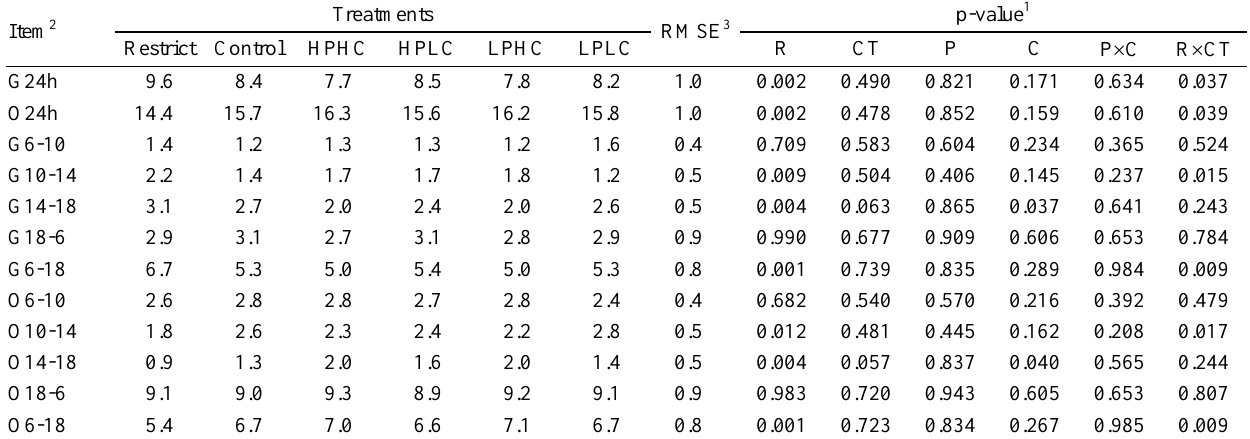
Table 4. Effect of nutritional plan (least square means, h) on grazing behavior measured by activities sensor